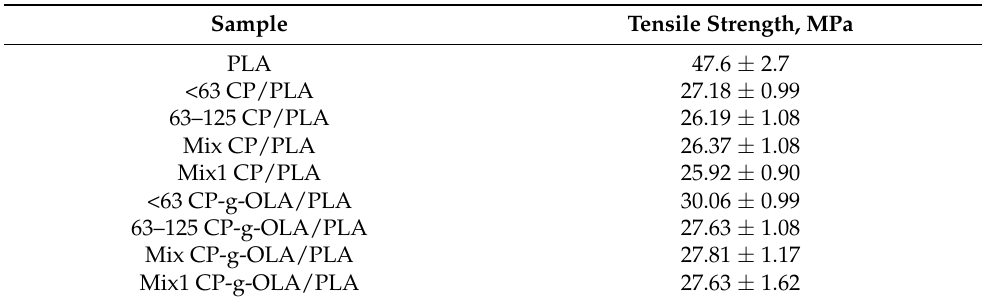
Table 11. Mechanical properties of biocomposites.